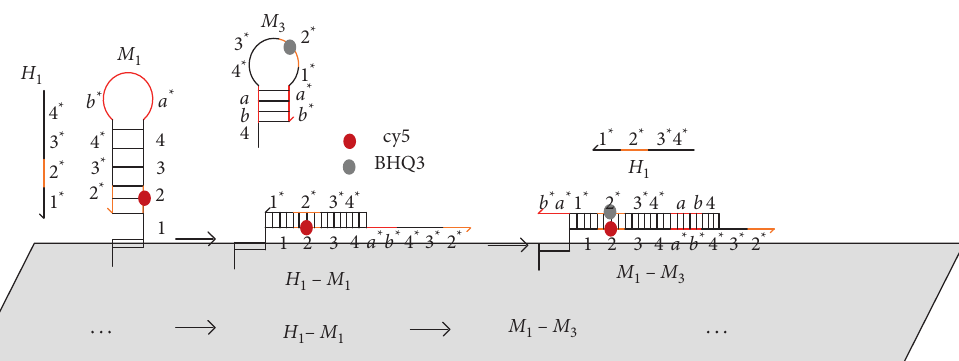
Figure 10: Cyclic reaction of NAND gate.